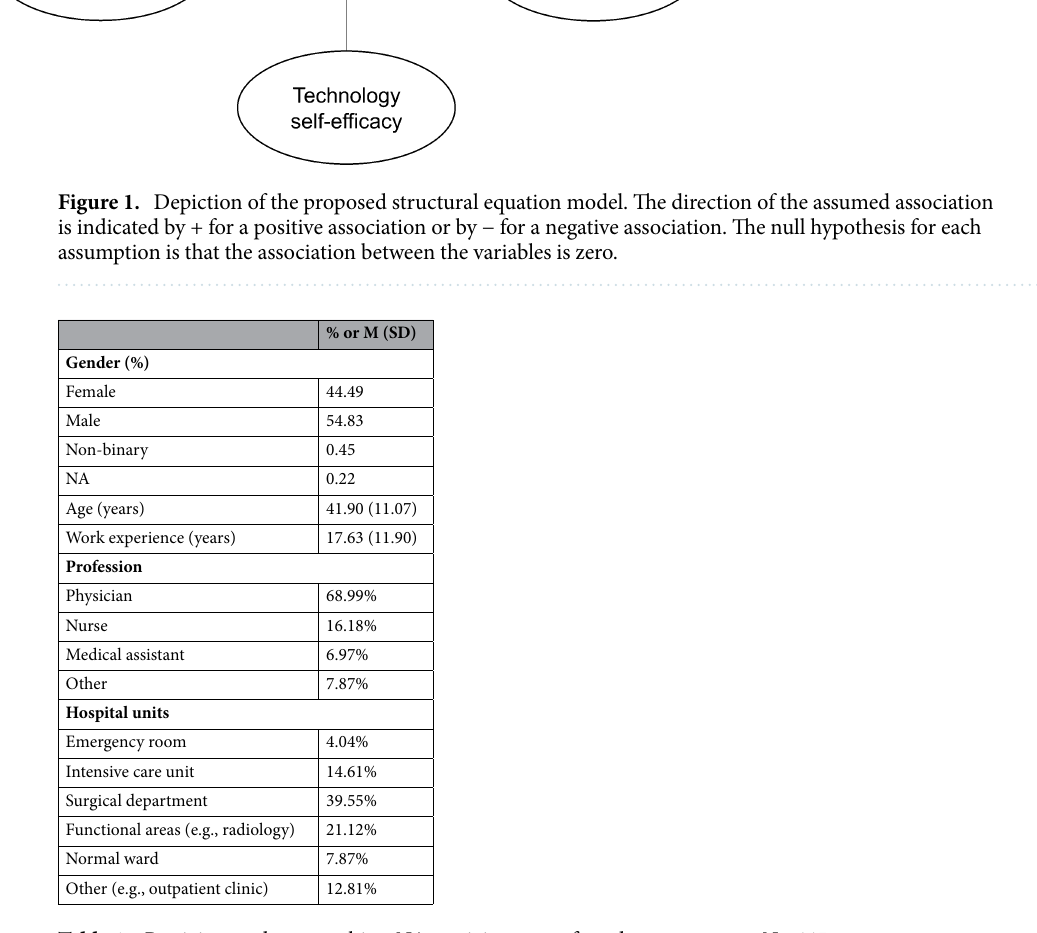
Table 1. Participants demographics. NA participants preferred not to answer. N =